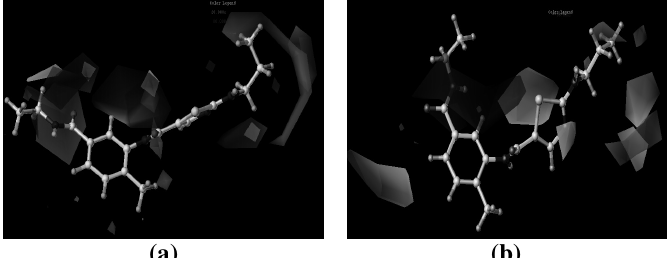
Figure 6. CoMFA steric standard deviation (S.D. * coefficient) contour maps illustrating steric and electrostatic features in combination with compound 2g (a) ligand based (b) Receptor based. Green contours show favorable bulky group substitution at that point while yellow regions show disfavorable bulky group for activity. Red contours indicate negative charge favoring activity, whereas blue contours indicate positive charge favoring activity.